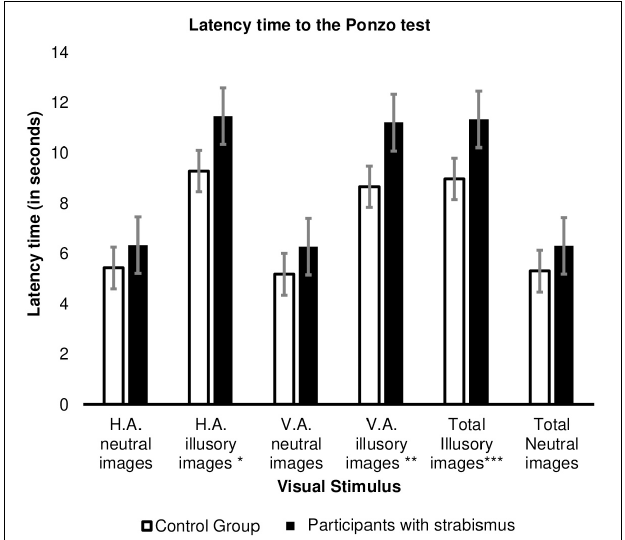
FIGURE 3 | Response time (in seconds) to adjust the image between the Cases ( n = 45) versus Control Group ( n = 62) in the Ponzo test. HA, horizontal adjustment images; VA, vertical adjustment images; * p -value = 0.007, ** p -value = 0.008, *** p -value = 0.004. The error bars shown represent the Standard Error.